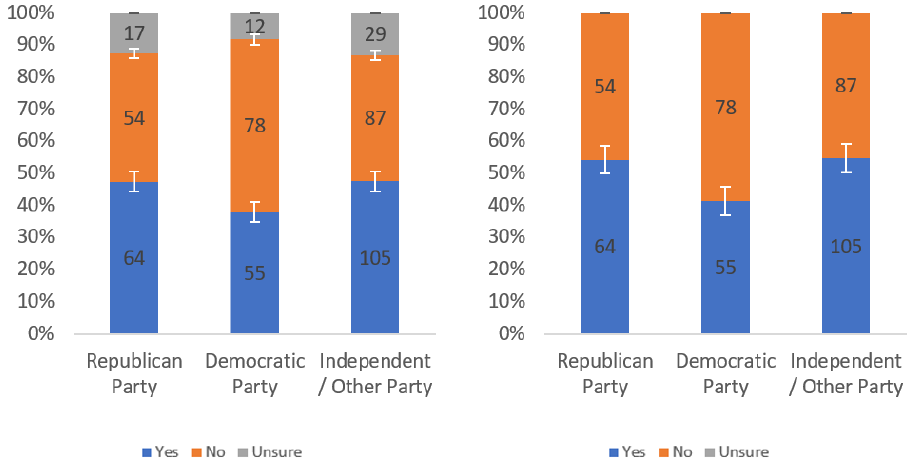
Figure A35. Responses regarding label annoyingness by party affiliation including ( left ) and excluding ( right ) unsure responses.